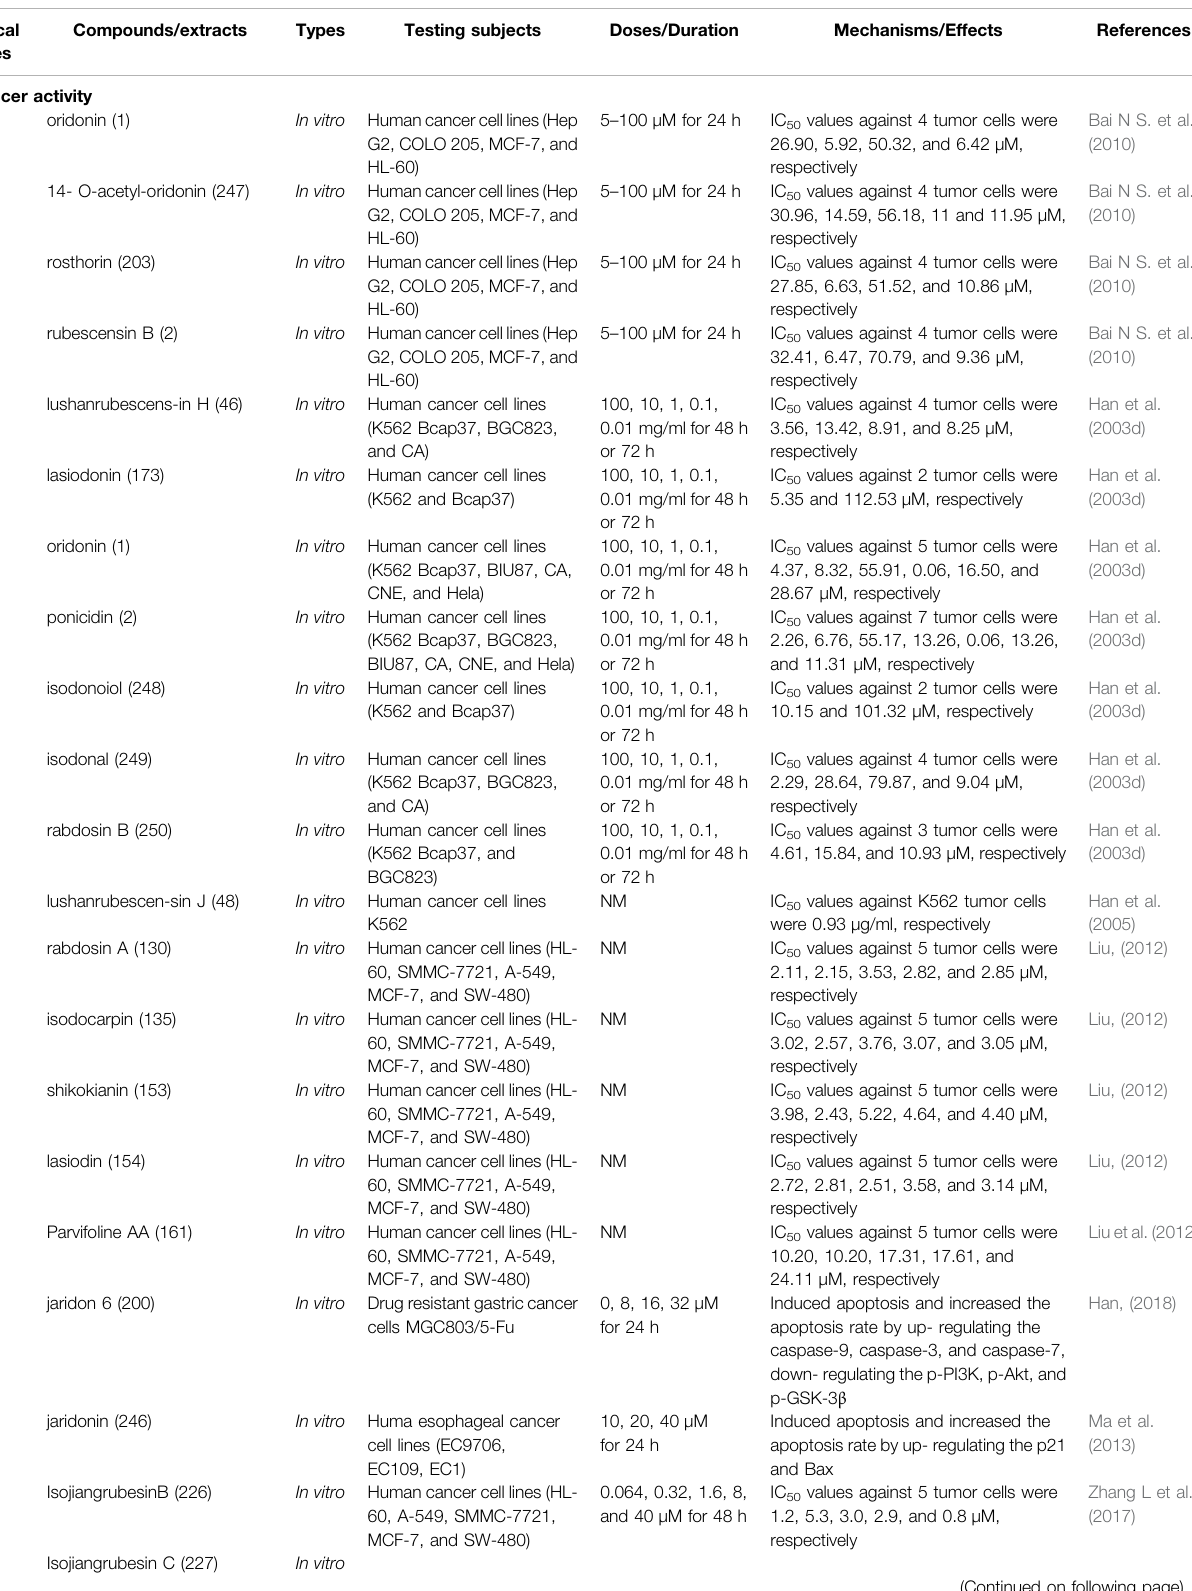
TABLE 3 | Biological activities of bioactive compounds and extracts of I. rubescens